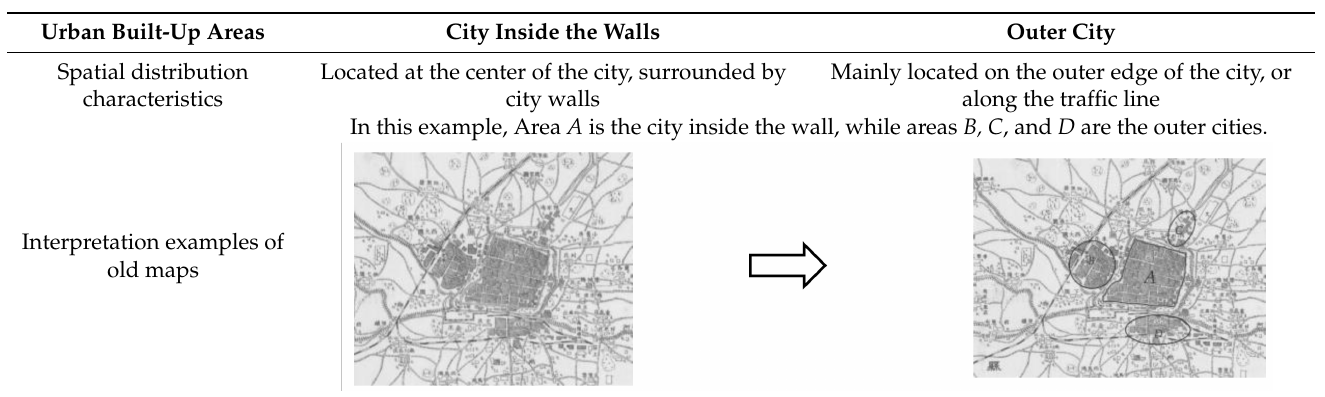
Table 2. Map recognition of urban built-up